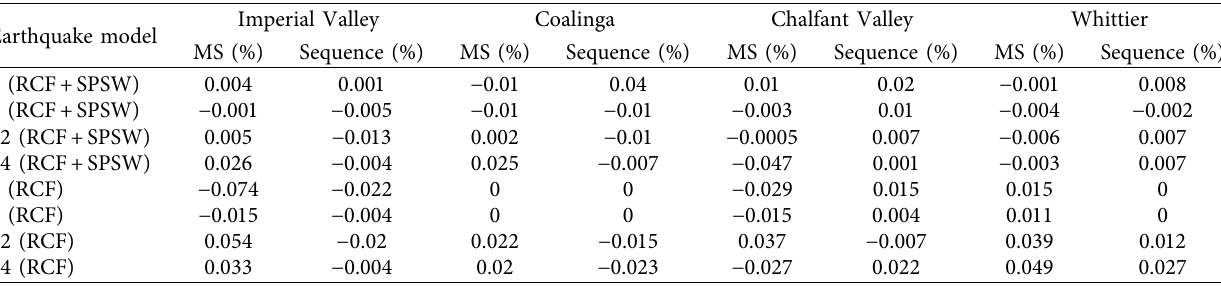
Table 21: Results of residual drift analysis of models under the MS and SS group III. Earthquake model